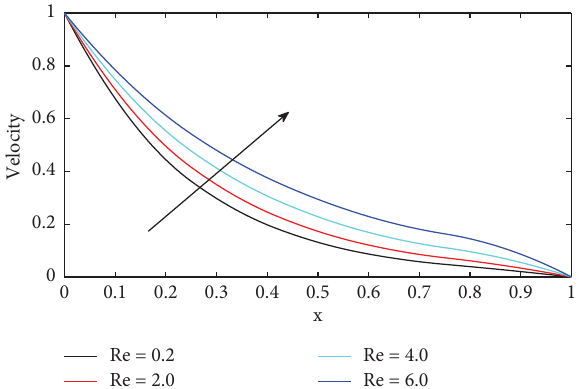
Figure 7: Velocity profles for diferent values of Re.